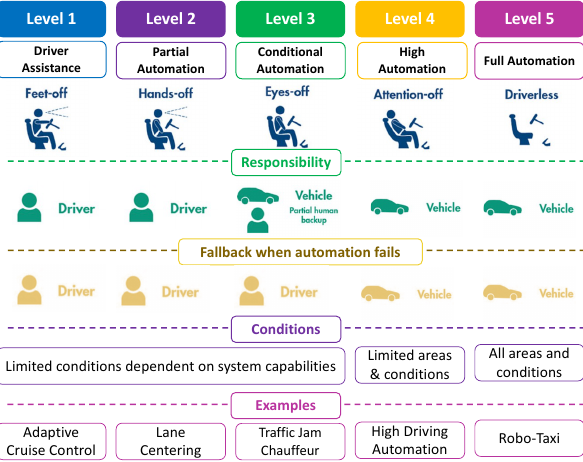
Figure 1. SAE Levels of Driving Automation.